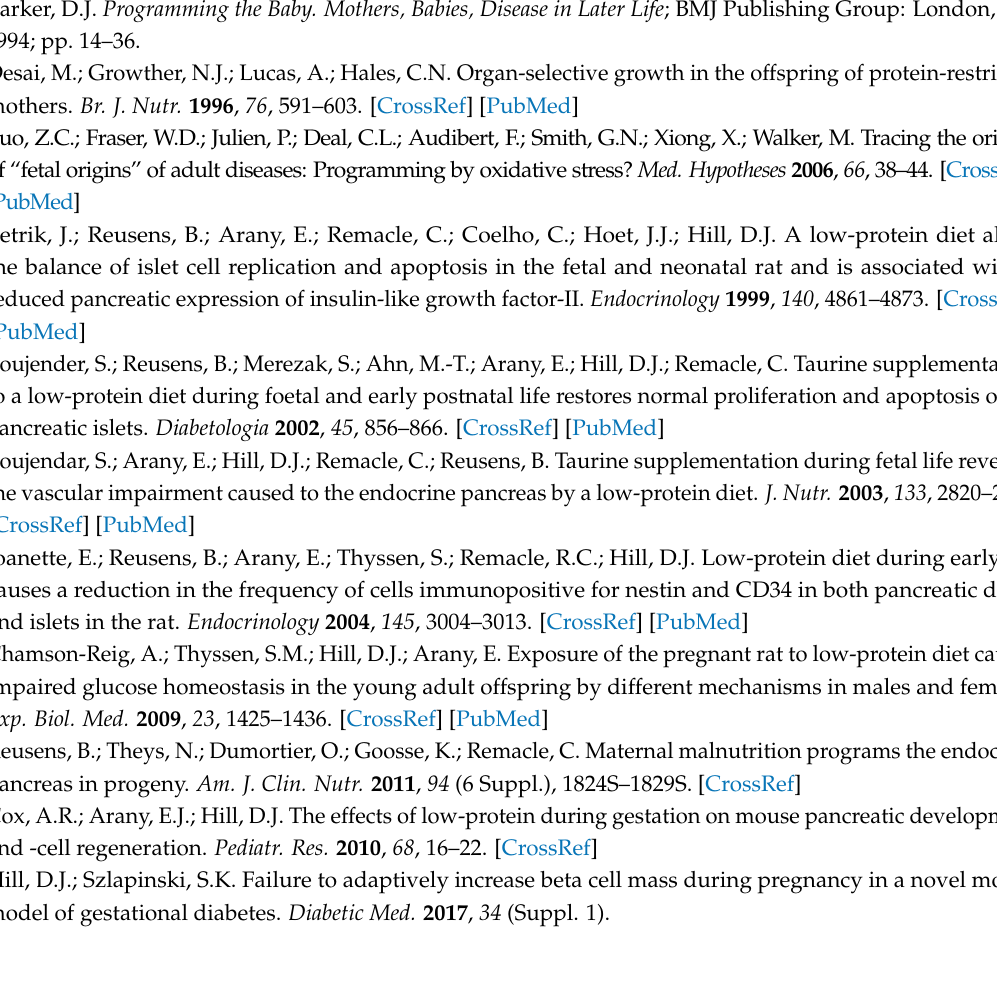
(mTOR) protein in isolated islets relative to β -actin at 7, 30 and 130 days. Figure S2: Immunohistochemical localization of mTOR in an islet from a 130-day-old control diet-fed mouse. Figure S3: Relative changes in phosphorylated mTOR activity determined by western blot relative to β -actin in the α − cell line α TC1-6 or the β -cell line MIN6 cells. Figure S4: Effect of rapamycin on cell proliferation and apoptosis is isolated pancreatic islets from a 30-day old mouse that had received control diet. Figure S5: Immunofluorescence localization of STING in a mouse islet from a 30-day old control diet-fed mouse. Table S1: Composition of the isocaloric LP and control diets. Table S2: Primer source and amplicon sizes for primers utilized for quantitative real-time PCR analysis, and forward and reverse primer sequences for TSC2 and